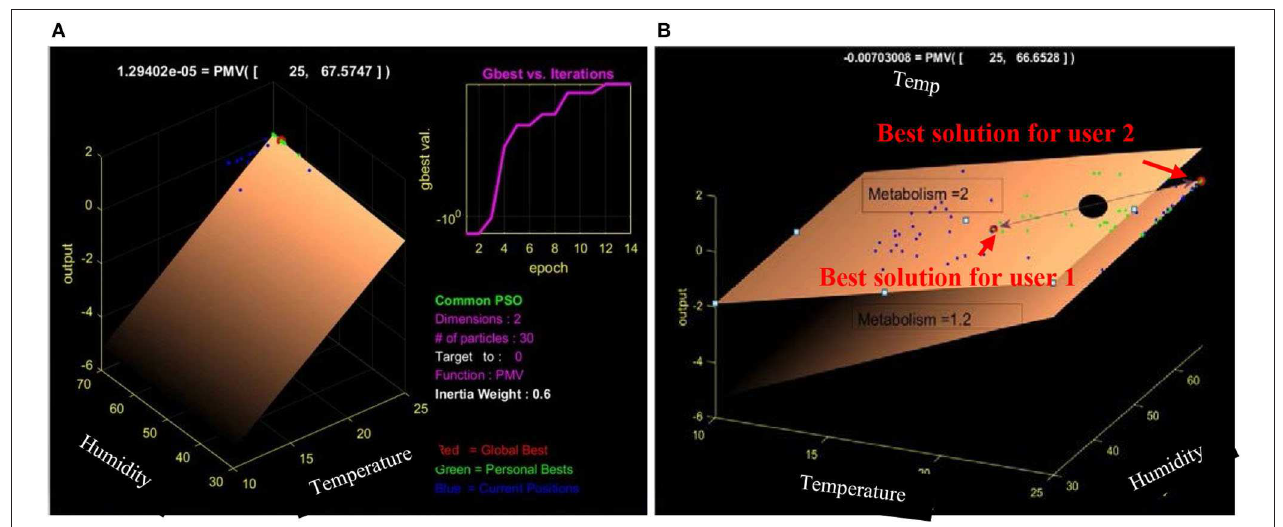
FIGURE 10 | Simulation example for the PSO to search for the best comfort control parameters for: (A) one user, (B) two users. Blue circles represent the particles, green circles are the local best particles, and the red circle is the best global particle.